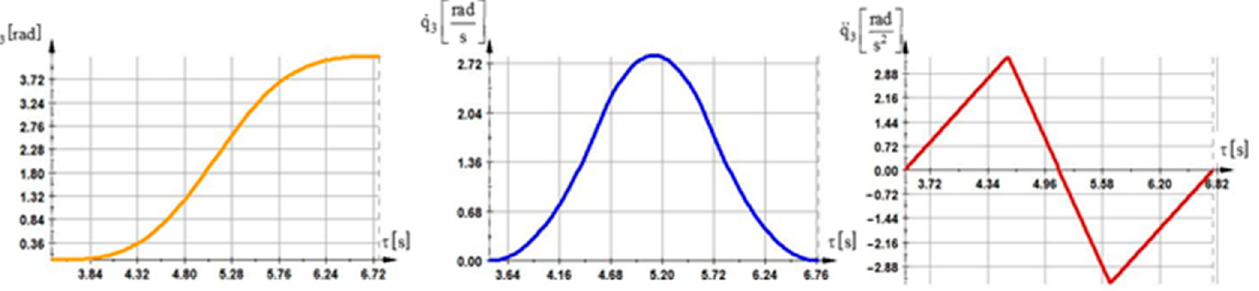
Figure 7. Expressions that vary with time for the generalized coordinates, speeds, and accelerations for kinetic joint j = 3.